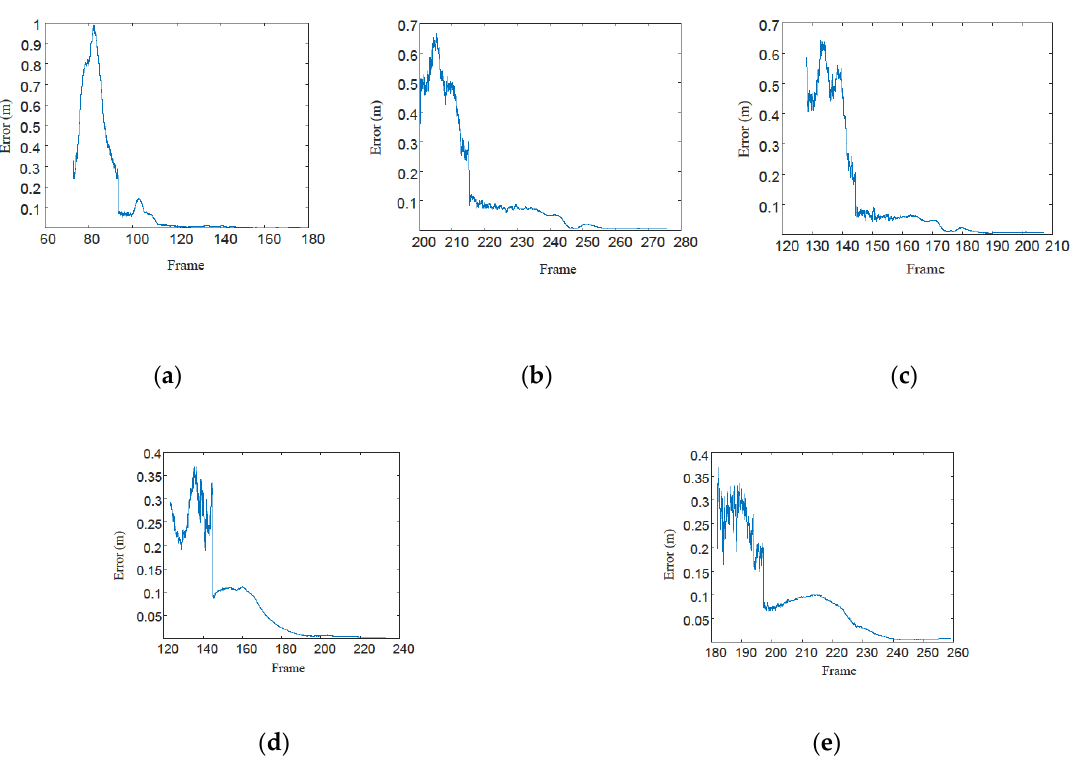
Figure 6. The positioning errors of GVO (Visual Odometer integrated with GPS). ( a ) 100 m height. ( b ) 200 m height. ( c ) 300 m height. ( d ) 400 m height. ( e ) 500 m height.